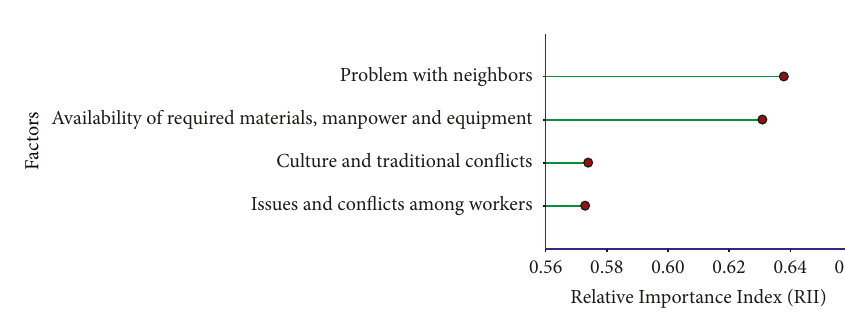
Figure 9: Ranking of external environment-related